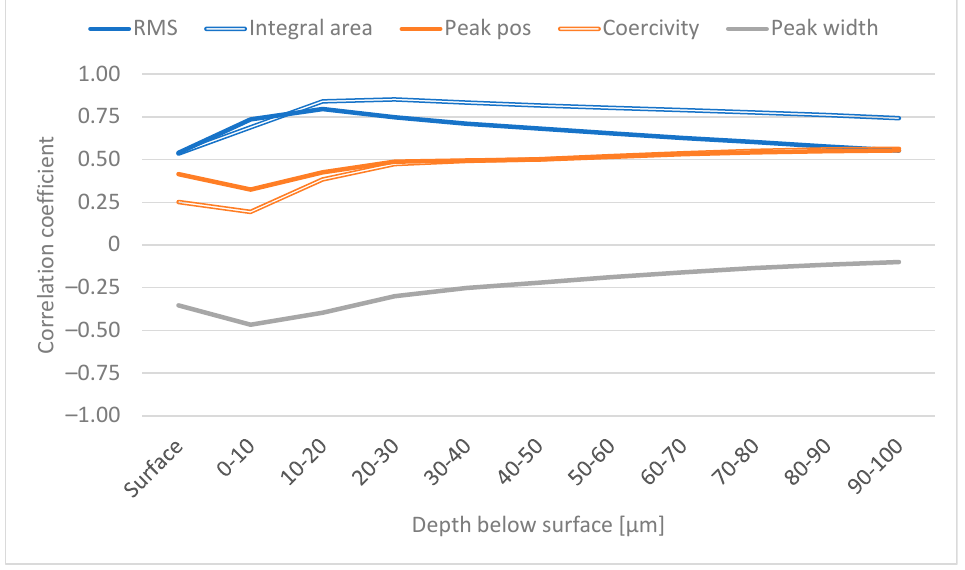
Figure 4. Correlation coefficient between selected BN features and RS (tangential).